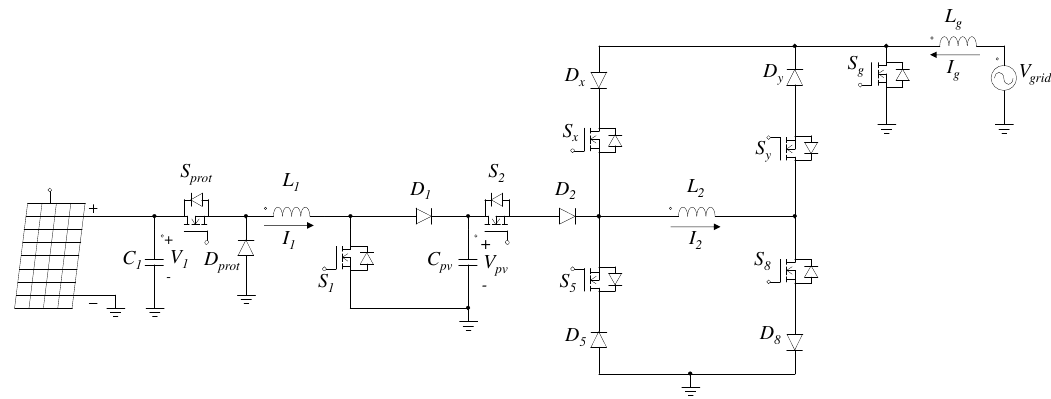
Figure 6. Circuit of the converter when the vehicle is parked in the sunlight.